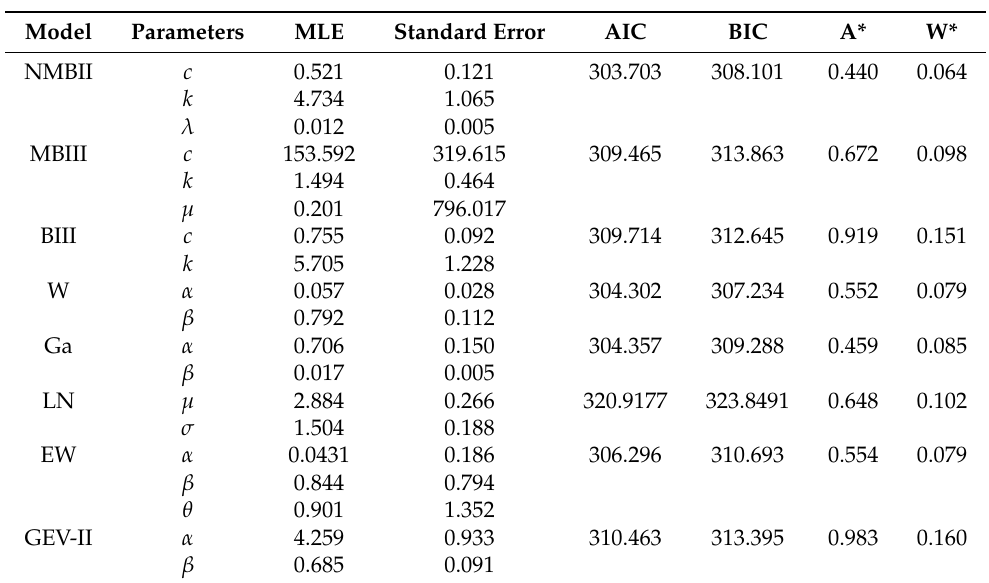
Table 6. Data set 3.